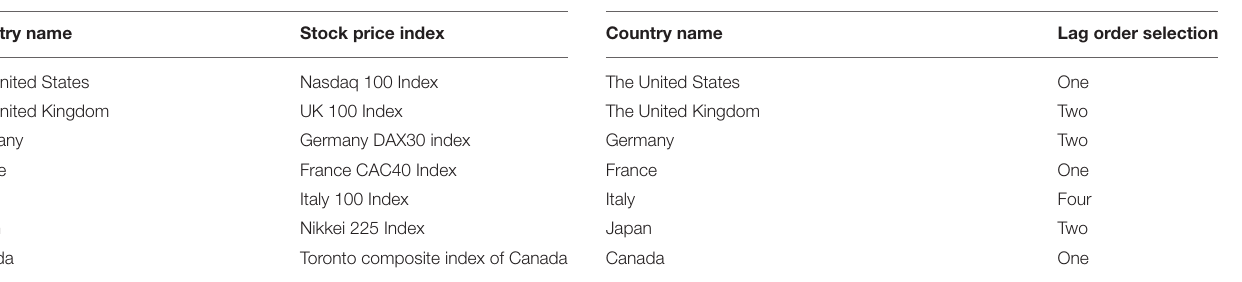
TABLE 1 | Stock price index selection of sample countries. TABLE 2 | Lag order selection of TVP-VAR-SV